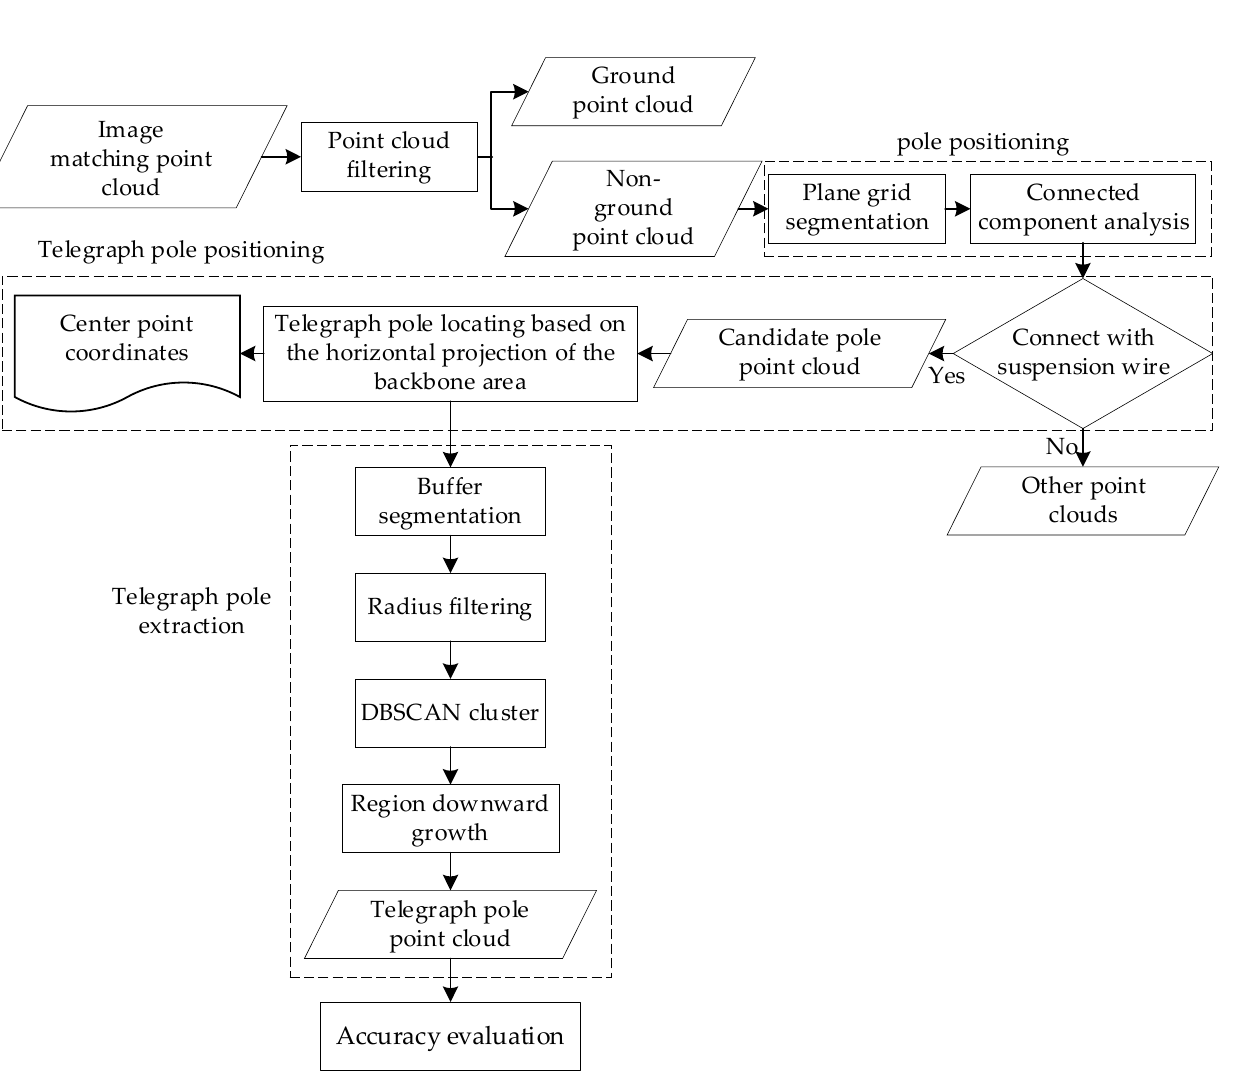
Figure 2. Flow chart of location and extraction of multi-level telegraph poles.